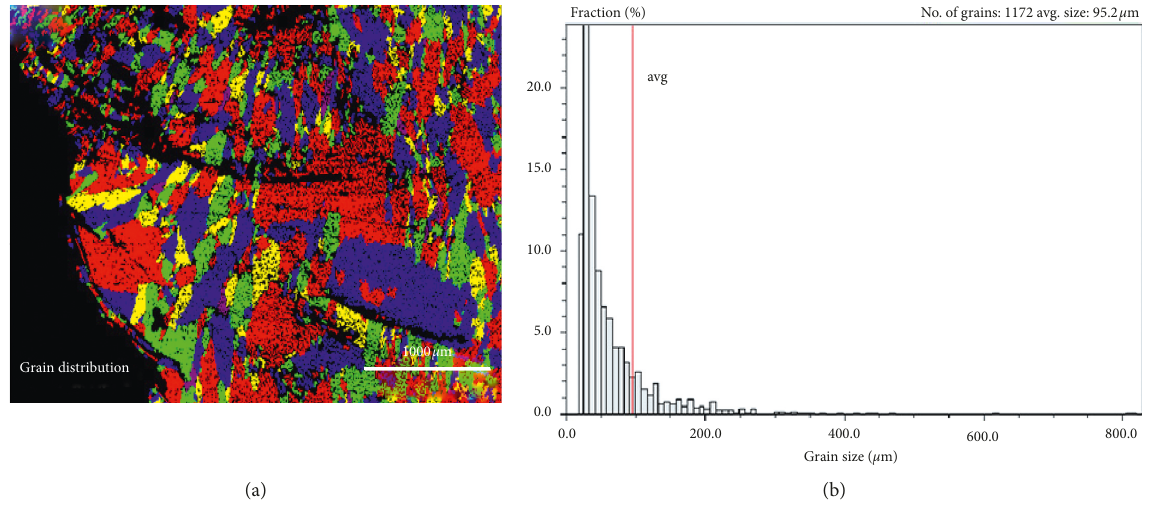
Figure 15: Grain size of weld: (a) grain size and (b)